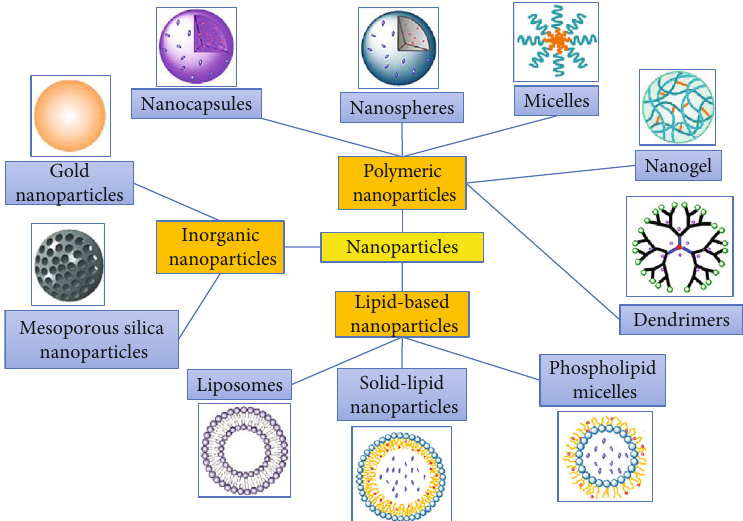
Figure 3: The representative examples of currently studied nanoparticles (polymeric, lipidic, and inorganic) for cancer